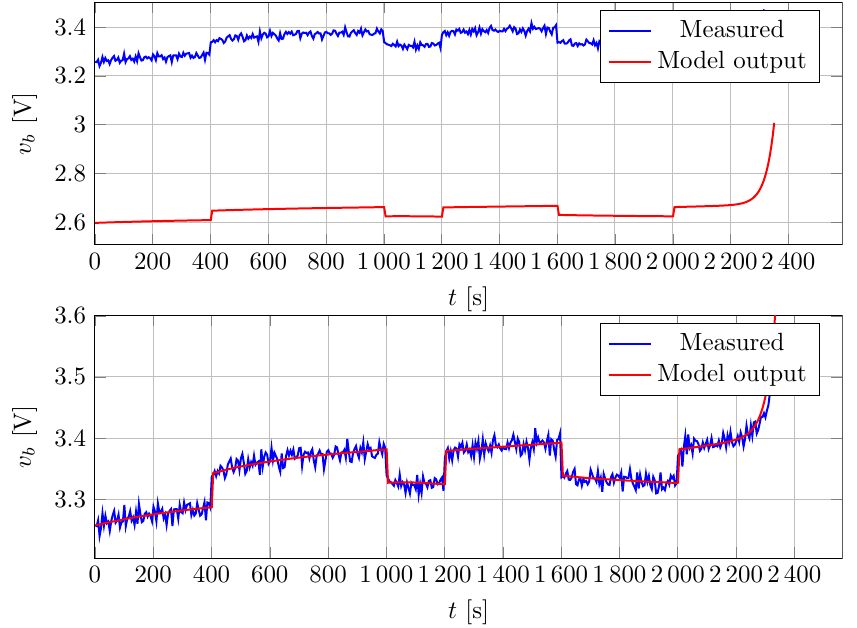
Figure 8. The measured battery voltage and the battery model output voltages for the initial parameter set ( top ) and after the last (sixth) parameter estimation step ( bottom